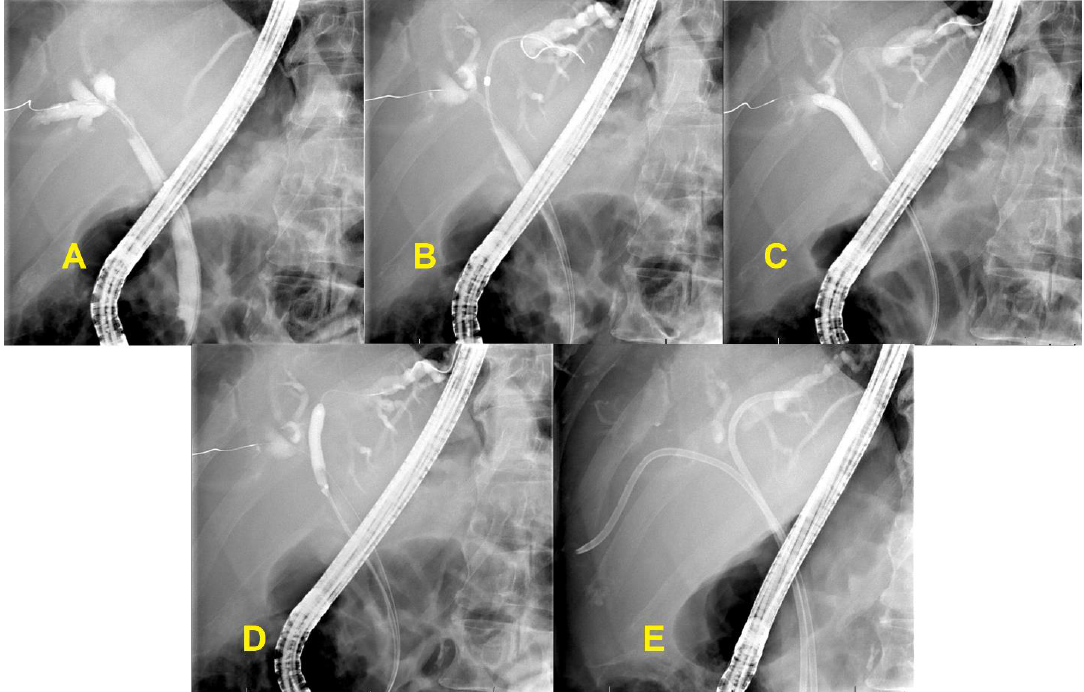
Figure 2. Hilar cholangiocarcinoma. ( A , B ) Hilar stricture with dilated right and left intrahepatic biliary tree; ( C , D ) Balloon dilatation of hilar stricture; ( E ) Bilateral plastic stents